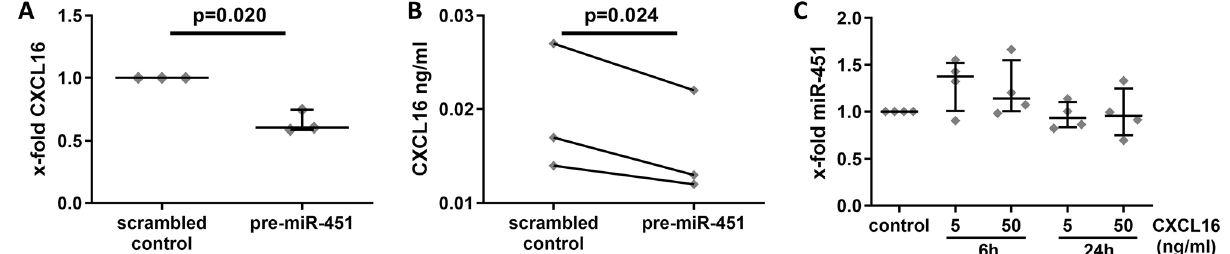
Figure 5. Regulation of miR-451 and CXCL16 in monocytes. Transfection of monocytes with pre-miR-451 downregulates the expression of CXCL16 at the ( A ) mRNA and ( B ) protein levels. ( C ) Stimulation of monocytes with CXCL16 tends to upregulate